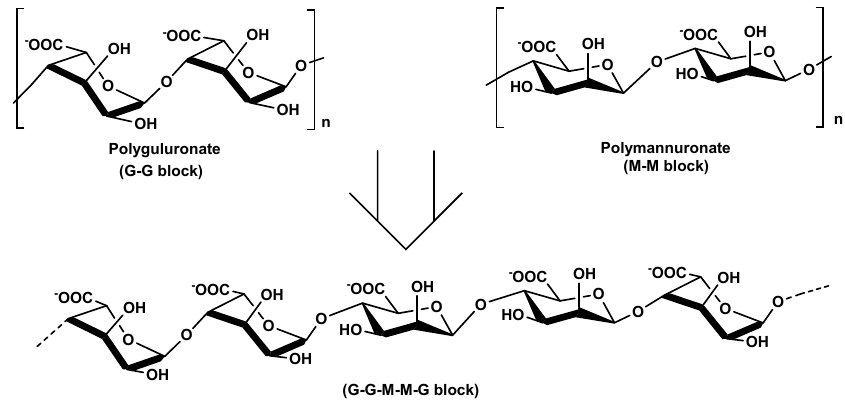
Figure 13. Mains chemical structure of seaweed alginates.